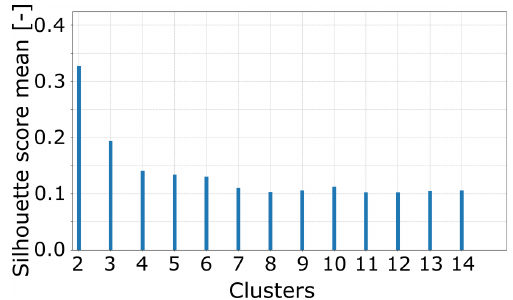
Figure 6. Mean of silhouette scores per cluster